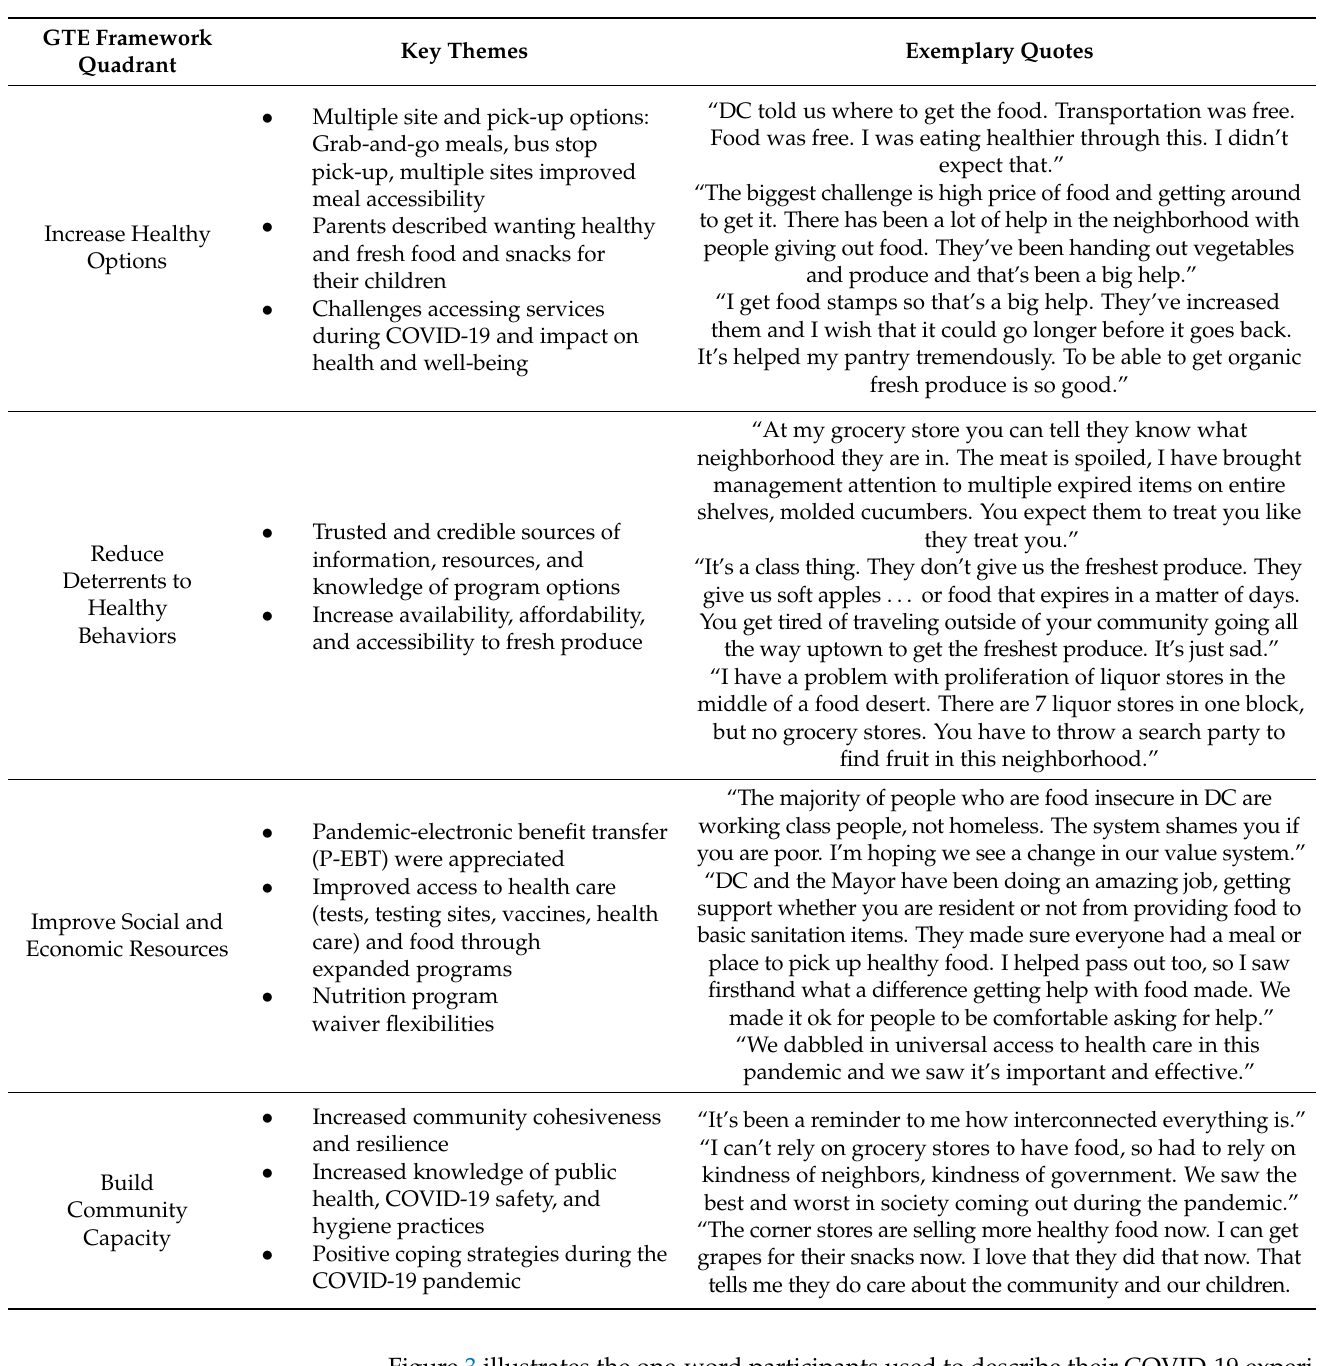
Table 3. Key themes and participant quotes by GTE